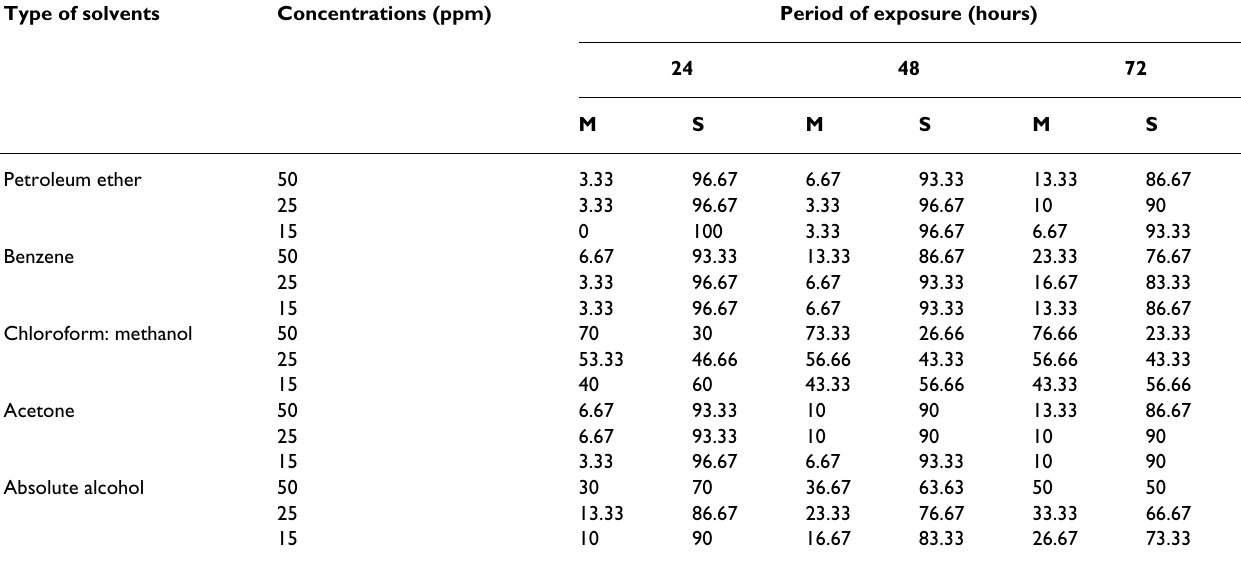
Table 2: Efficacy of different concentrations of polar and non-polar solvent extracts of the green berries of S. villosum on third instar larvae of S. aegypti . M, mortality (%); S, survivality (%). Type of